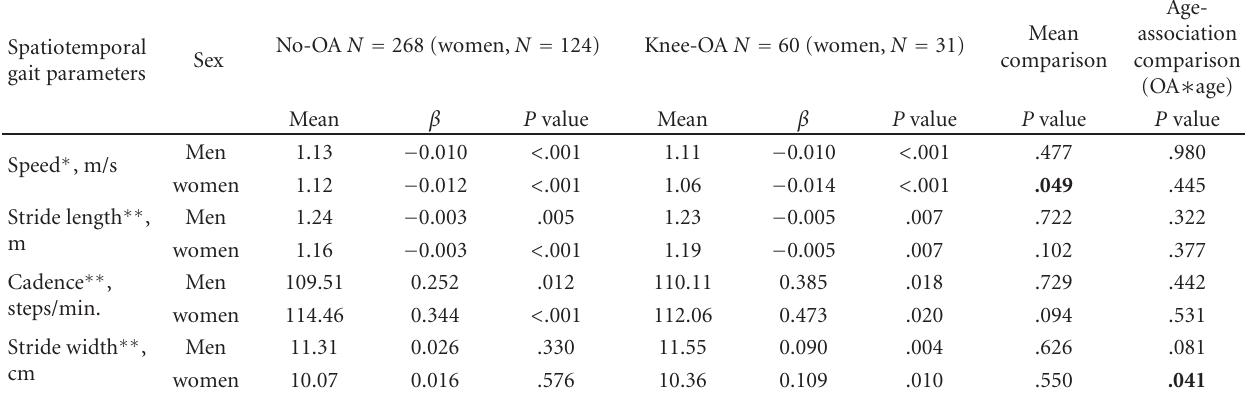
Table 2: Spatiotemporal gait parameters in men and women with and without knee-OA.